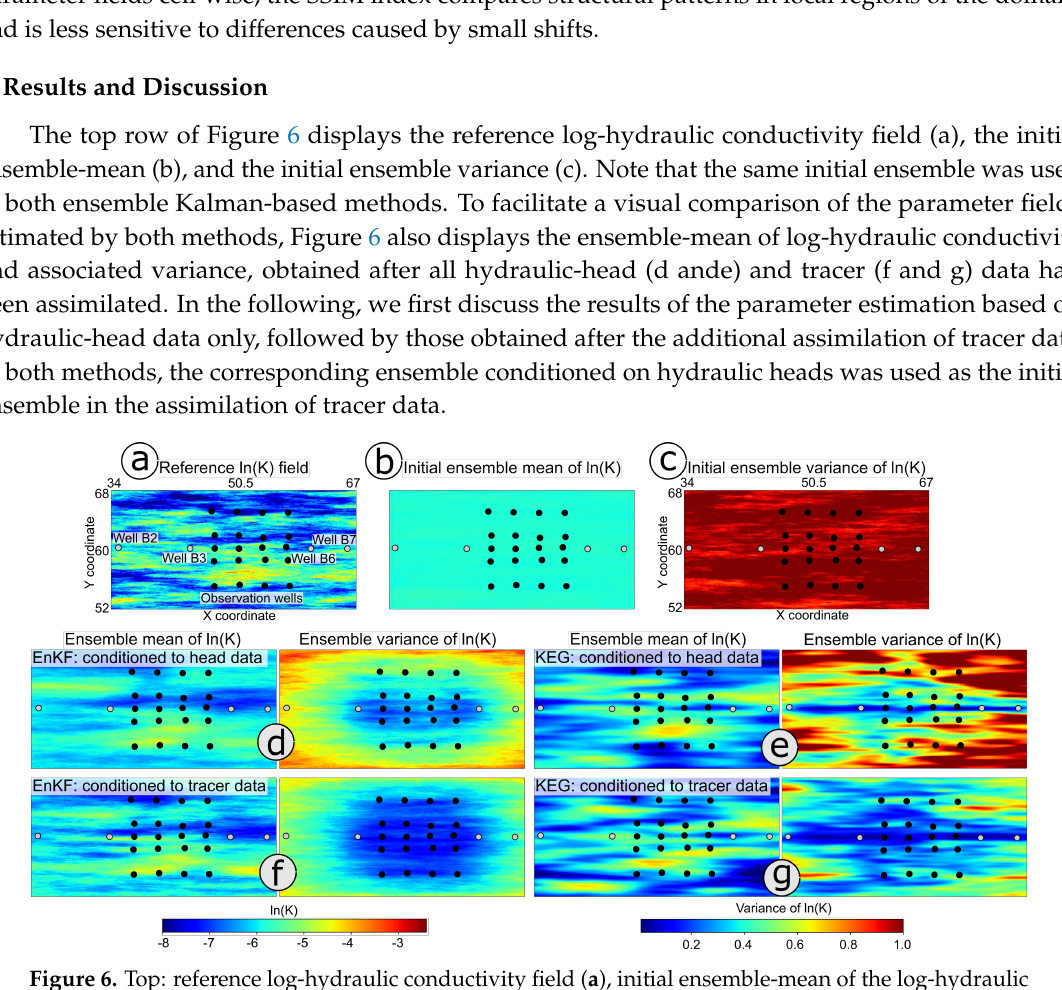
Figure 6. Top: reference log-hydraulic conductivity field ( a ), initial ensemble-mean of the log-hydraulic conductivity field ( b ), and initial ensemble variance of log-K ( c ). Middle: ensemble-mean of the log-hydraulic conductivity conditioned to all hydraulic-head data and its associated variance, estimated with the EnKF ( d ) and the KEG ( e ). Bottom: ensemble-mean of the log-hydraulic conductivity conditioned to all head and tracer data and its associated variance, estimated with the EnKF ( f ) and the KEG ( g ). White dots: injection/extraction wells. Black dots: observation